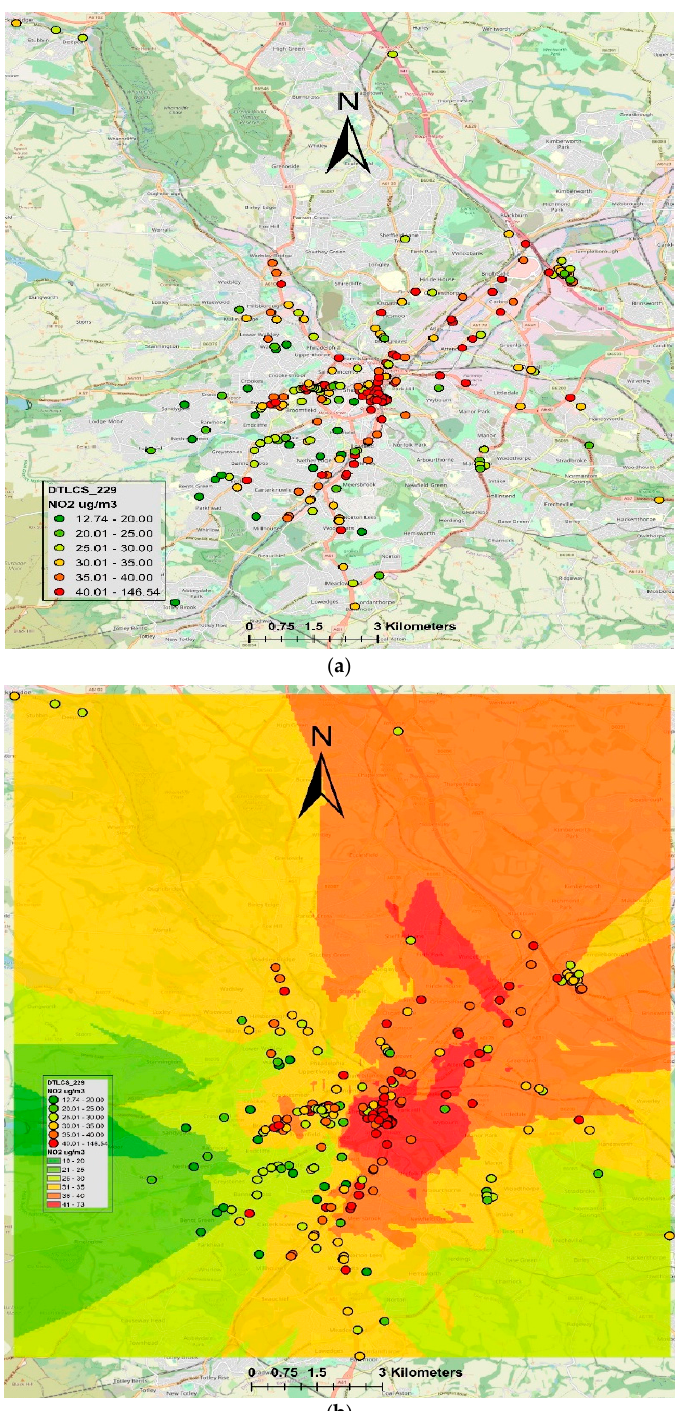
Figure 6. Showing point and interpolated NO 2 levels from both DT and LCS: ( a ) NO 2 concentra- tions (µg/m 3 ) from both 188 DT and LCS, and ( b ) interpolated NO 2 concentrations (µg/m 3 ) using ordinary kriging.